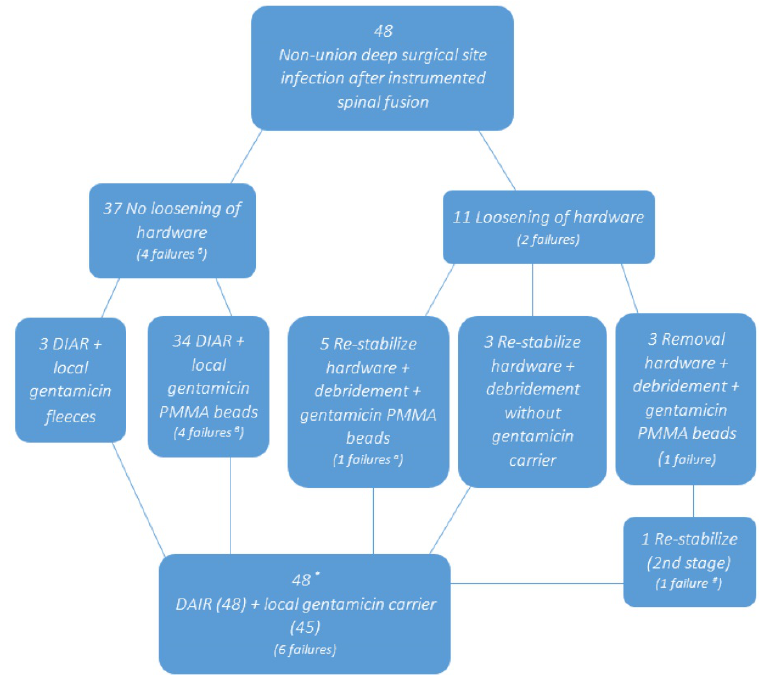
Figure 1. Treatment algorithm of deep surgical site infection after instrumented spinal fusion. * 45/48 infections were treated with debridement of the wound and a local gentamicin carrier (gentamicin fleeces in 3 SSI and gentamicin PMMA beads in 42 SSI) and 3/48 were treated without local gentamicin treatment because of very mild signs of a deep infection during operation. β 3/4 failures died sepsis-related during infection treatment. One failure presented with a recurrent infection with the same initial micro-organism ( Staphylococcus aureus ) that was successfully treated with removal of the instrumentation and local gentamicin PMMA beads. α 1 failure died during infection treatment because of sepsis. # 1 failure was a recurrence of infection of the anterior instrumentation that occurred more than 3 years after the secondary restabilization. This patient died during the second infection treatment because of a poor health condition (terminal metastatic renal